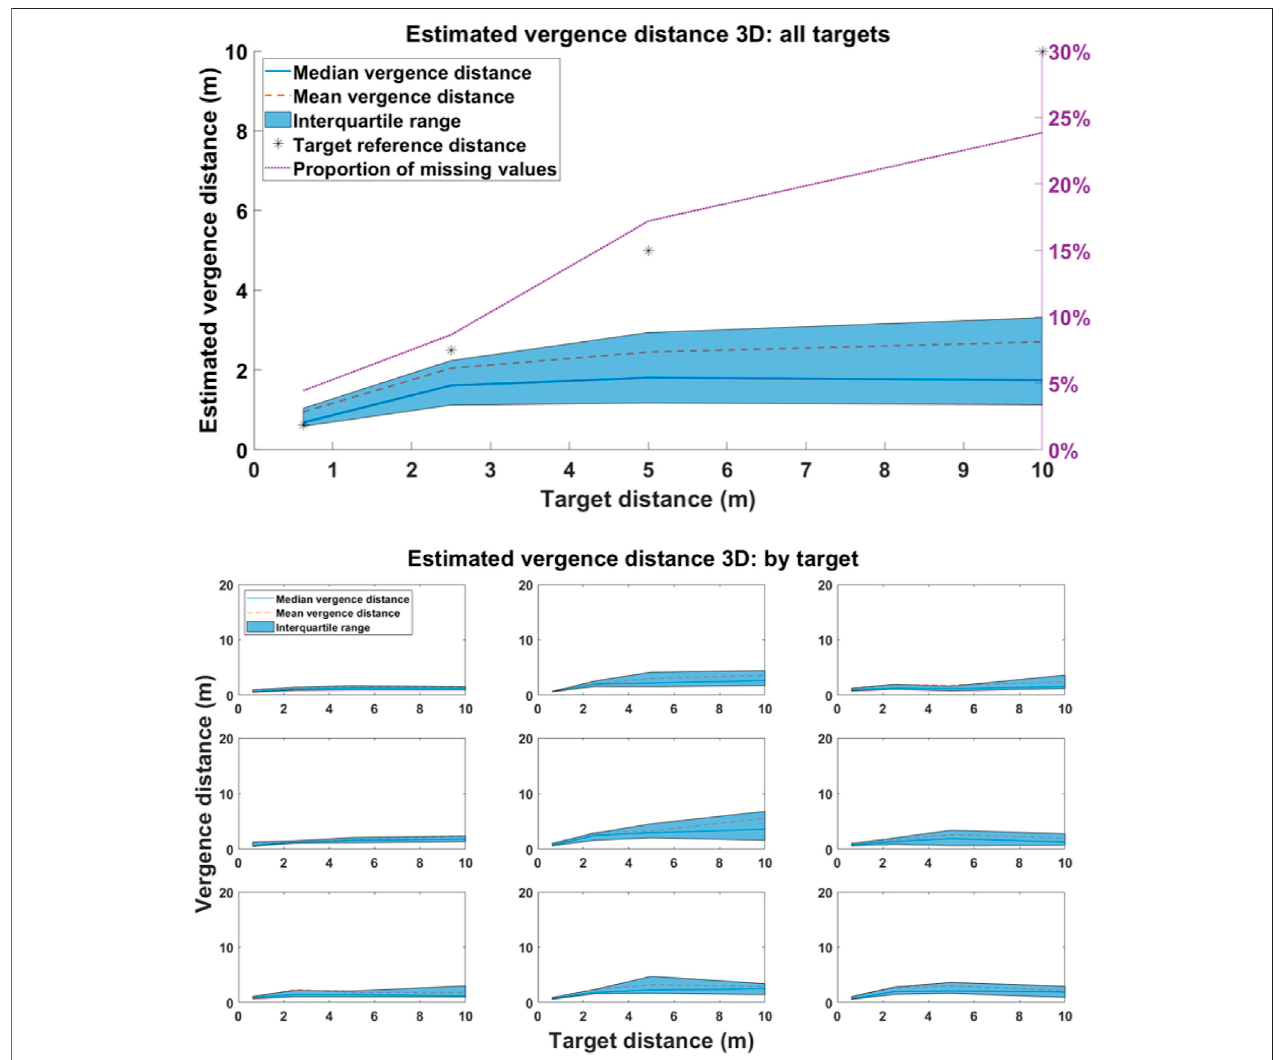
FIGURE 8 | Vergence depth estimates using the 3D distance estimation method ( Section 4.3 ). The upper plot illustrates distance estimates across all target positions at a given depth as well as the percentage of trials for which no valid solution was available. The lower plots illustrate the distance estimates per target at each